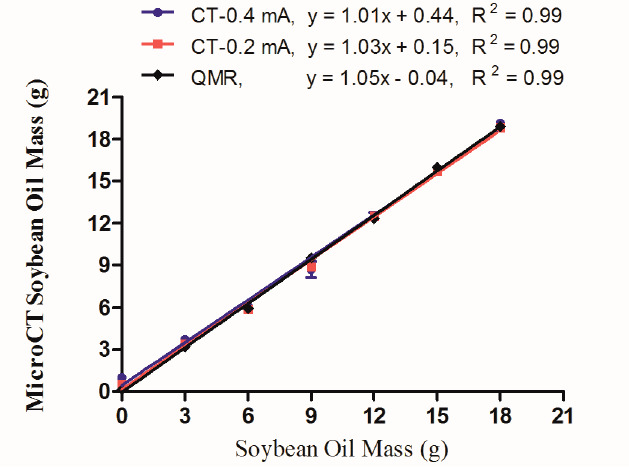
Figure 1. In vitro measurement of soybean oil masses as measured by QMR and microCT (0.4 and 0.2 mA currents)